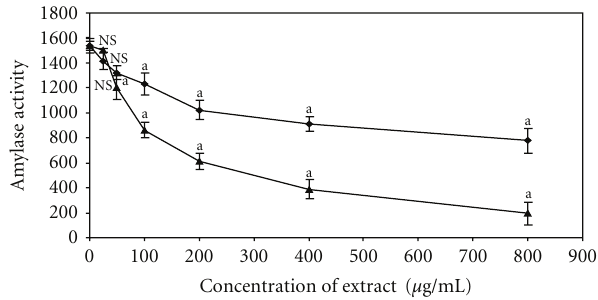
Figure 2: Graded concentrations of ethylacetate fractions of AM and FF on amylase activity in mouse plasma. The results are ex- pressed as mean ± S.E.M of seven observations in each group. Am- ylase unit expressed as described by Kobayashi et al. [25, 26] in mouse plasma. AM (circles) and FF (triangles). a P < 0 . 05 compared to control. NS, not statistically significant compared to control (without extract).